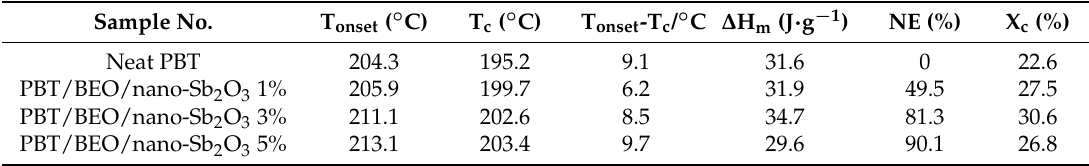
Thermodynamic parameters for the nonisothermal crystallization of neat PBT and its